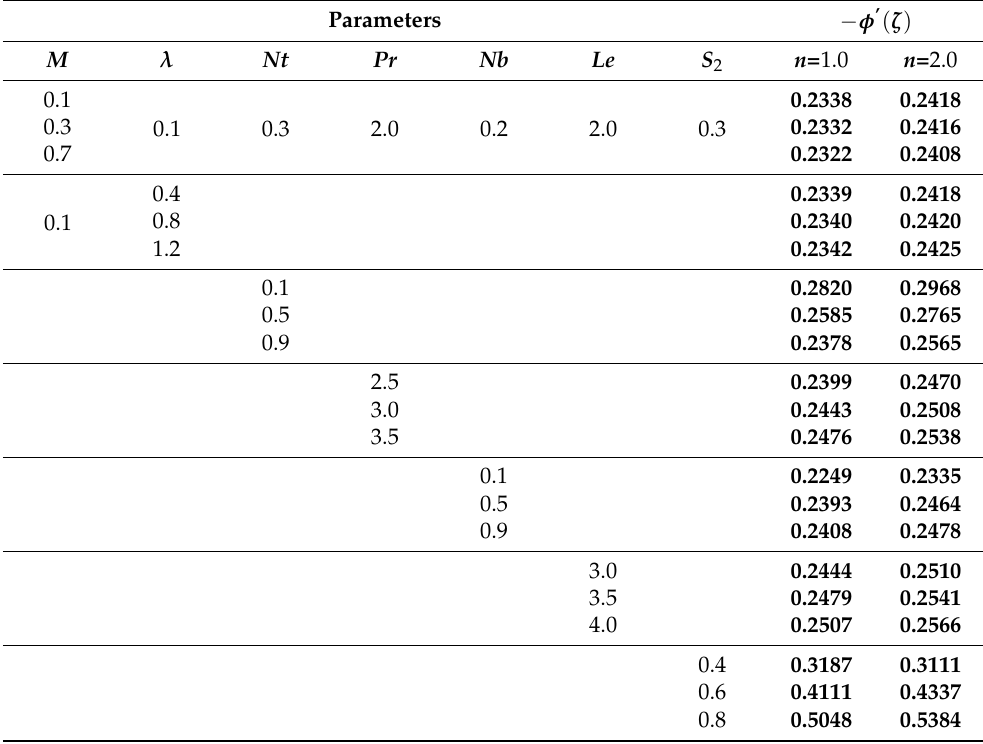
Table 4. Effect of flow factors over local Sherwood number − φ (cid:48) ( ζ ) at ζ =